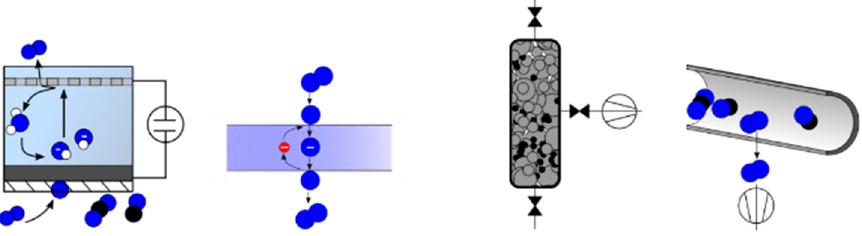
Figure 3. Possible processes for oxygen separation: electrochemically, mixed ionic electric conductor, adsorption, and diffusion.